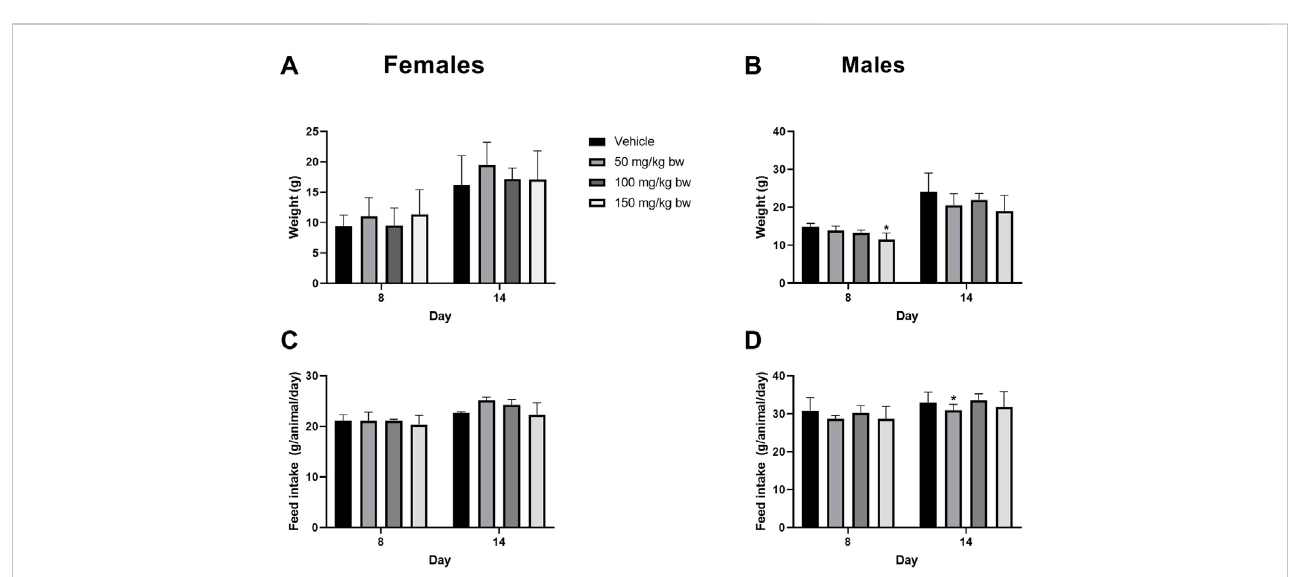
FIGURE 4 Body weight gain (%) relative to day 1 and feed consumption for females (A ,C) and males (B,D) in the repeat-dose 14-day toxicity study. Statistically signi fi cant compared to the control group at p < 0.05 (*)